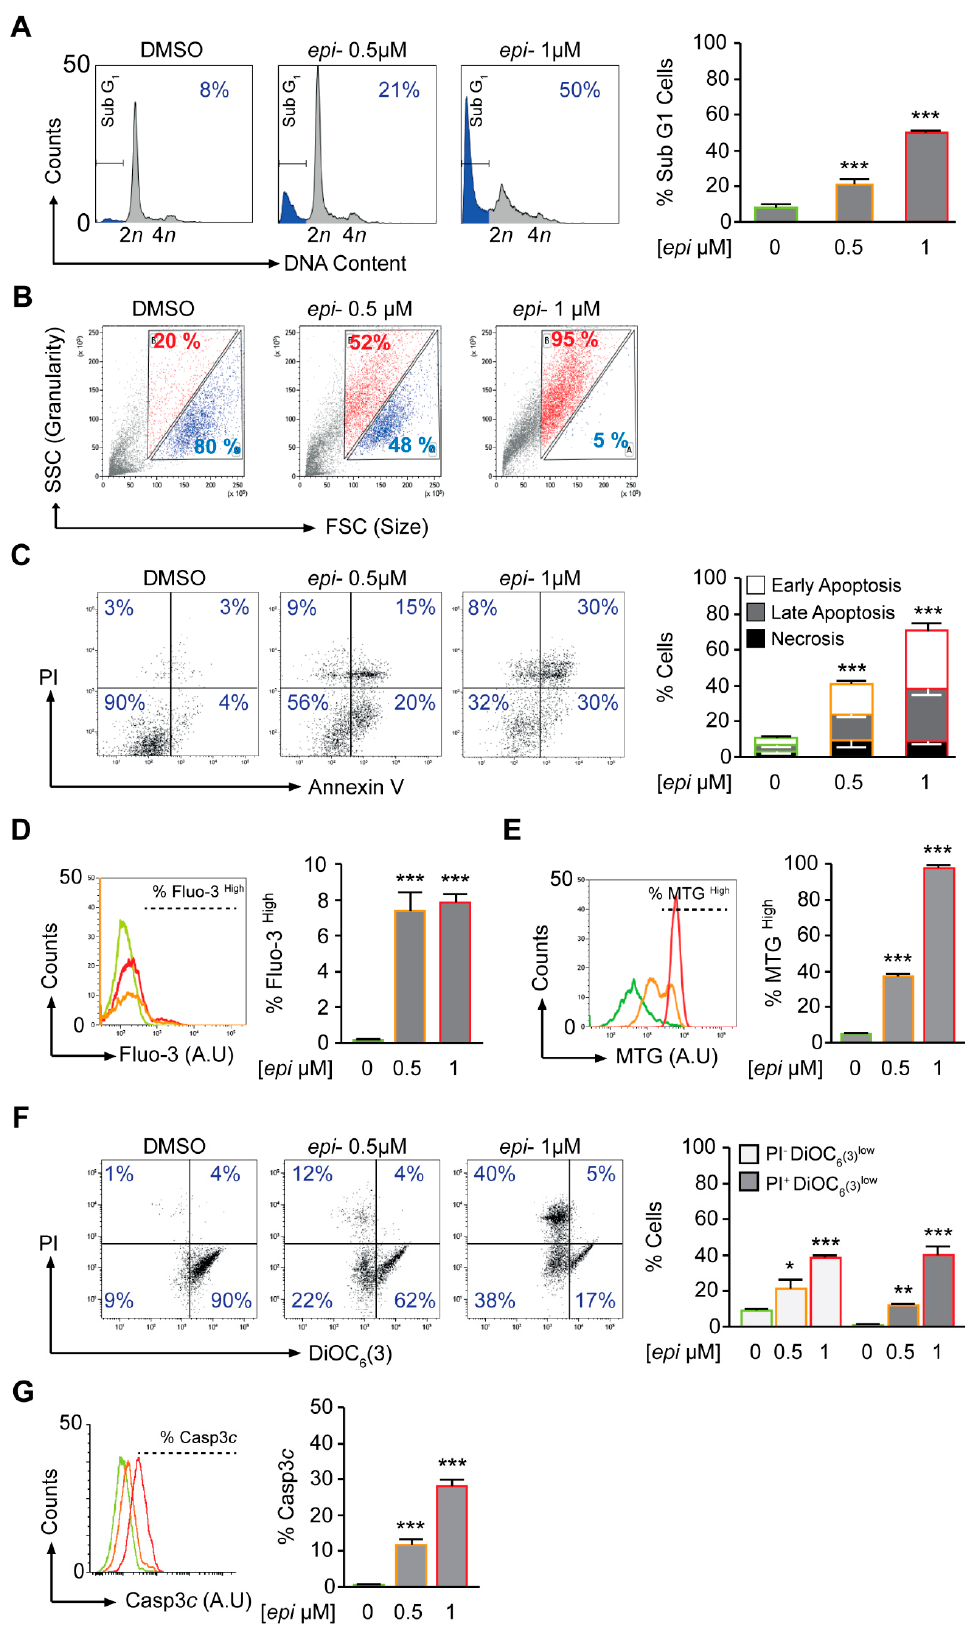
Figure 3. Epi -enprioline mediates cell death via the mitochondrial apoptotic pathway. ( A ) Cells were treated with epi -enprioline and stained with Hoechst 33342 for the quantification of the subG1